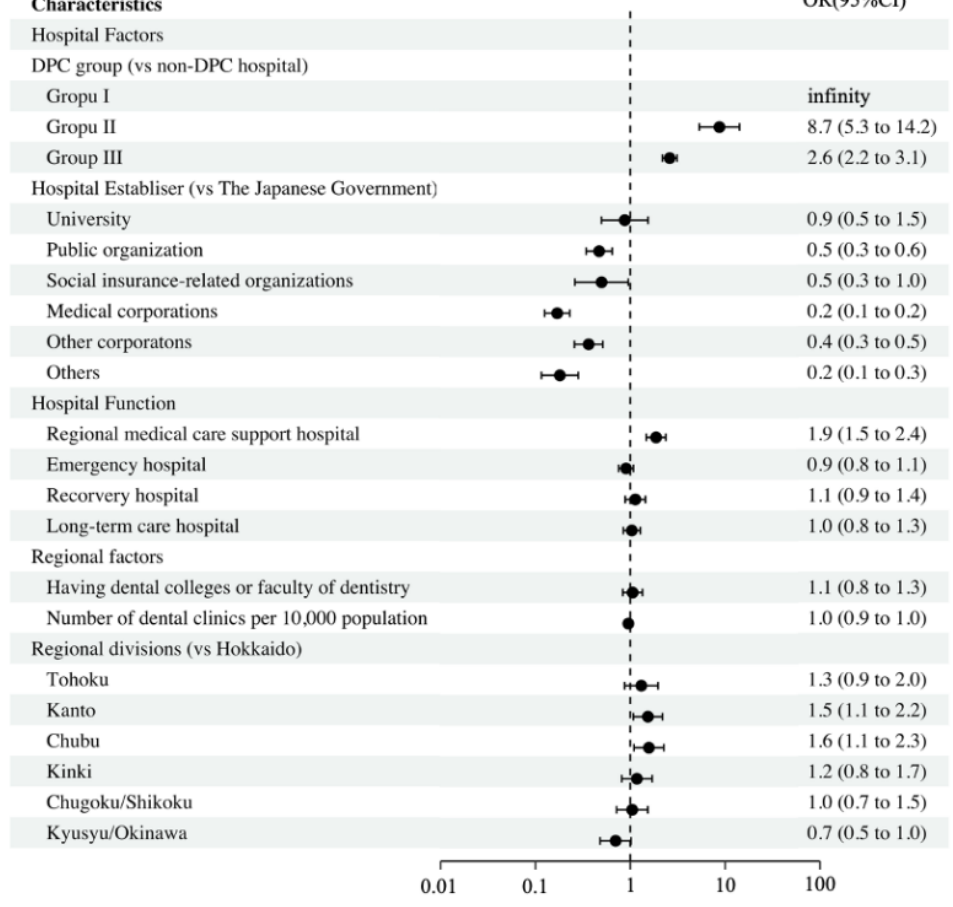
Figure 2. Factors associated with hospitals employing dentists. Abbreviations: OR, odds ratio; 95% CI, 95% confidence interval.